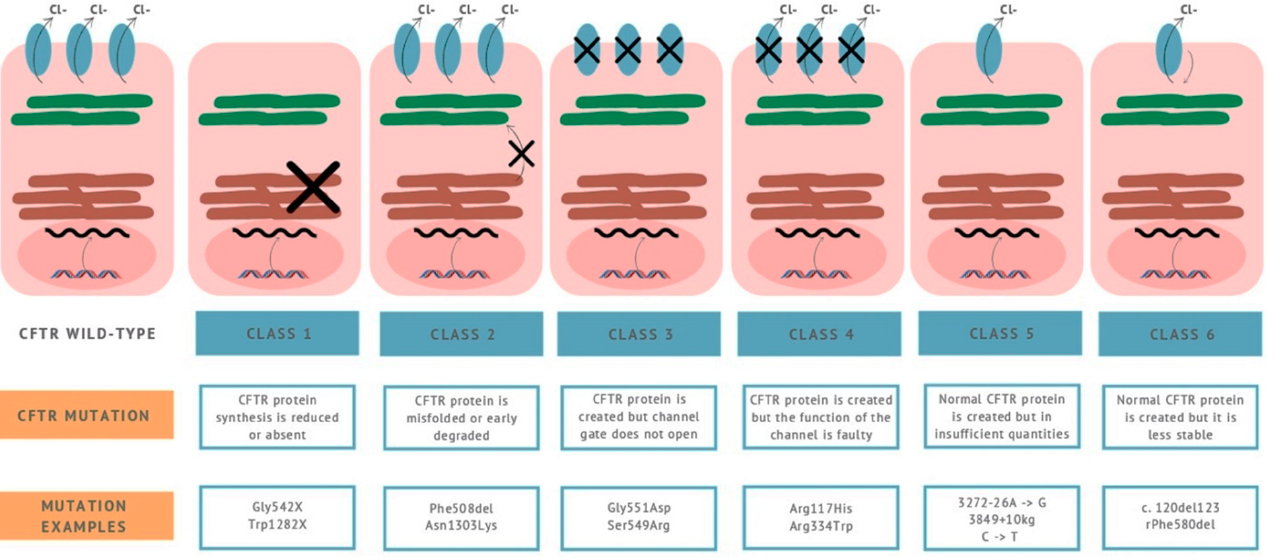
Figure 1. CFTR Mutation classes.